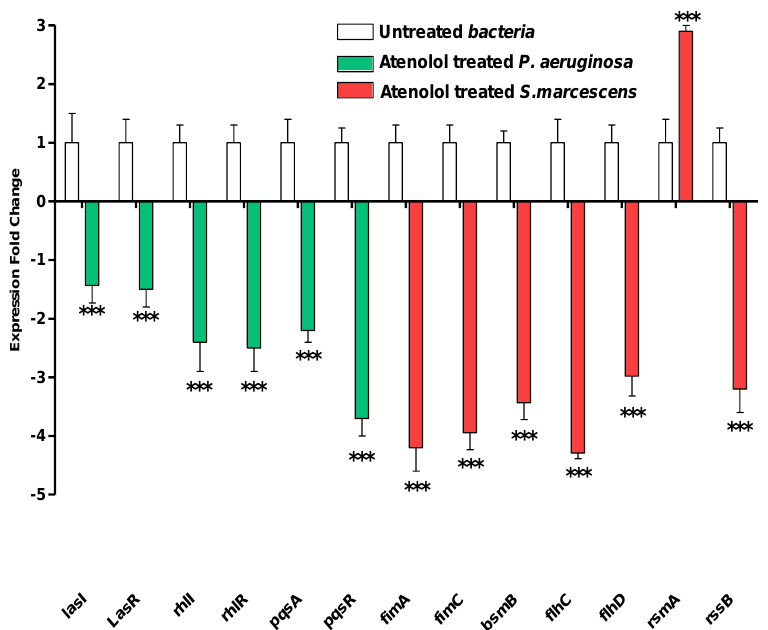
Figure 12. Atenolol reduced the expression of virulence and QS genes. The expression of S. marcescens motility and adhesion, and P. aeruginosa QS genes were evaluated in the presence of atenolol at sub– MIC. The expression of the tested genes was normalized to the expression of housekeeping genes rplU and rpoD in S. marcescens and P. aeruginosa , respectively (***: p ≤ 0.001).